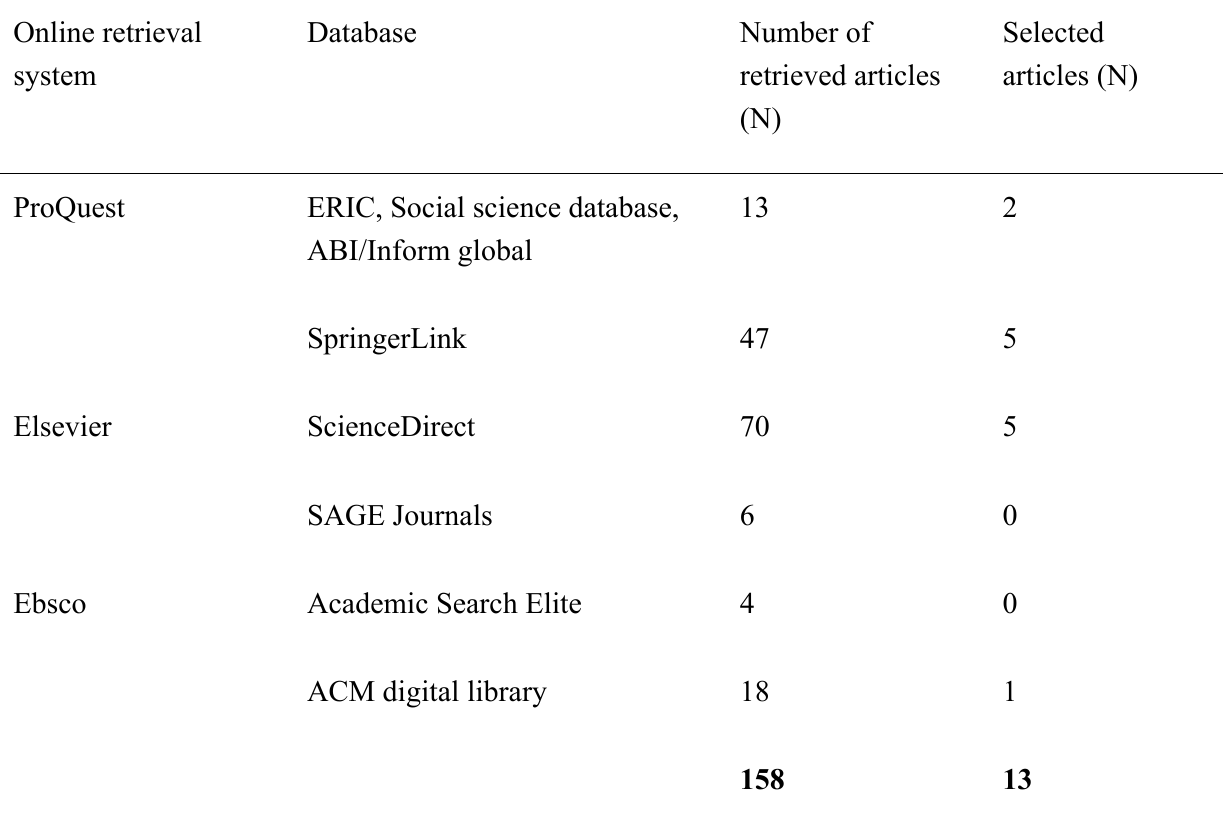
Number of the Retrieved Articles from Different Databases Online